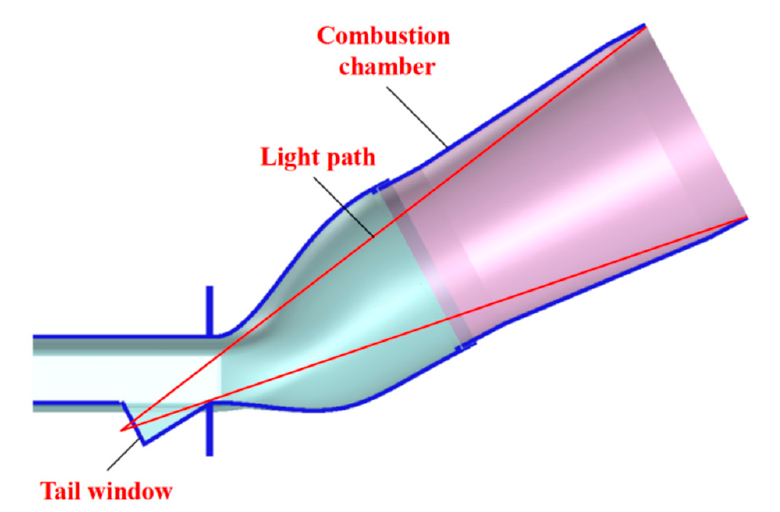
Figure 2. Light path inside the model.